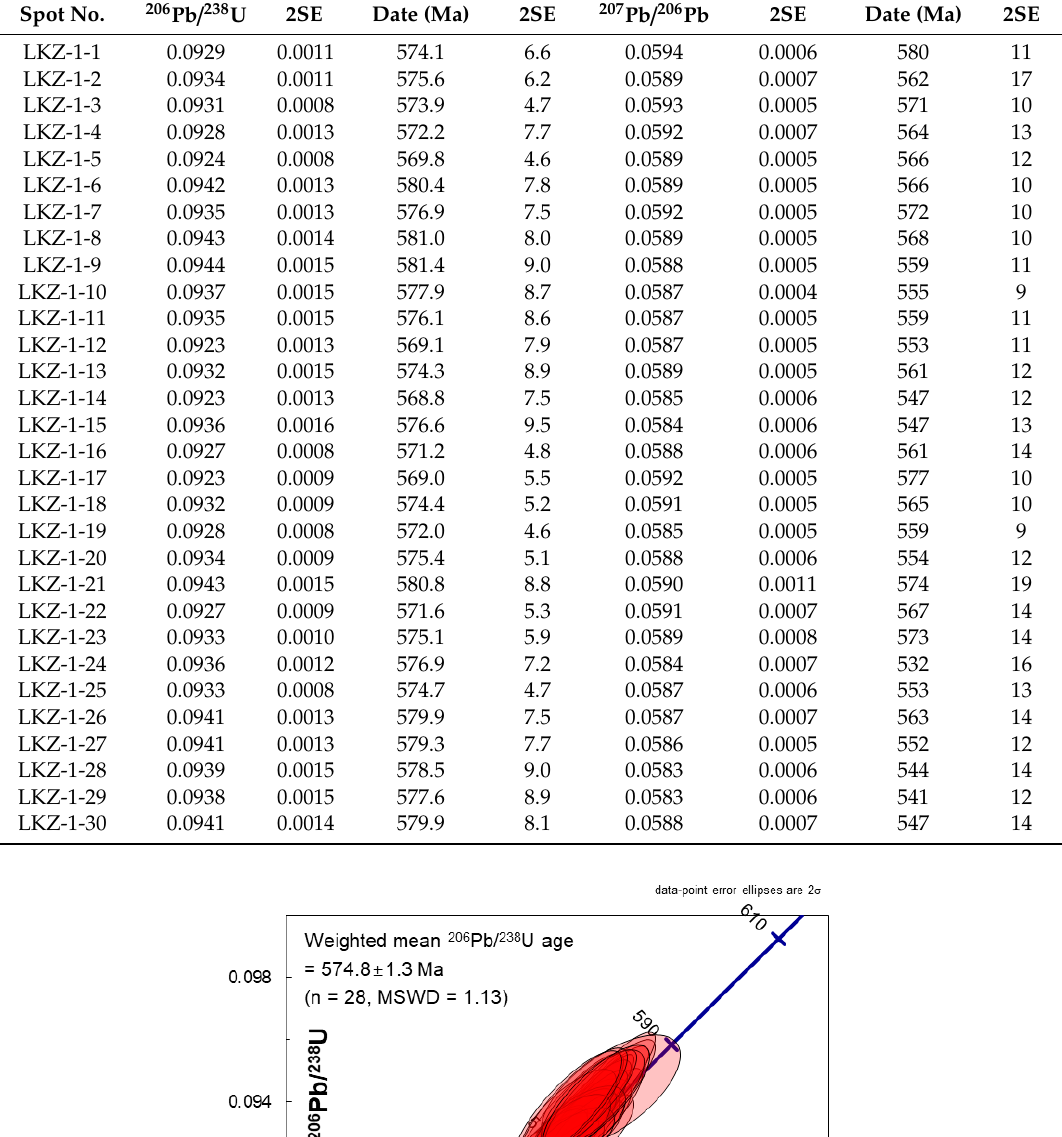
Table 3. LA-MC-ICPMS U–Pb results for the LKZ-1 zircon.